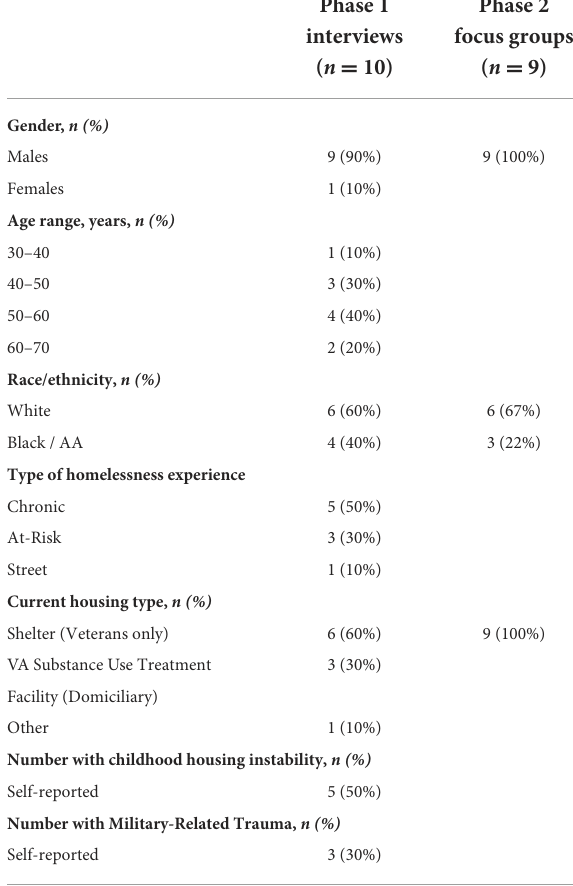
TABLE 2 Demographics of Phase 1 and 2